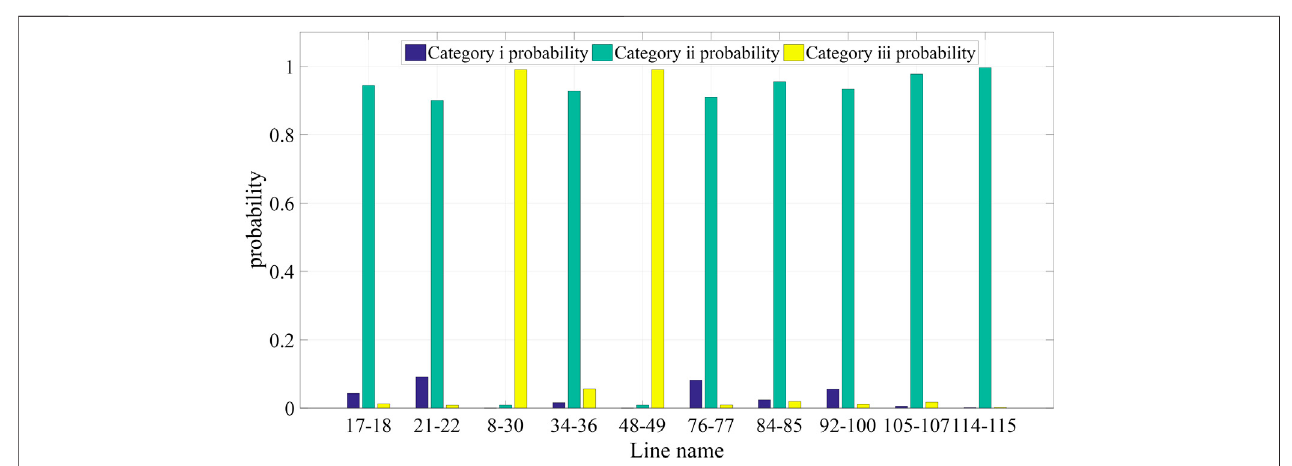
Frontiers in Energy Research |